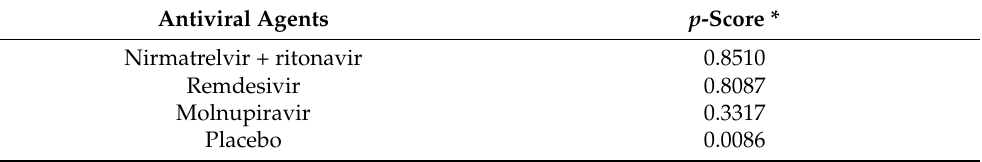
Table 3. Rank probabilities for treatment by